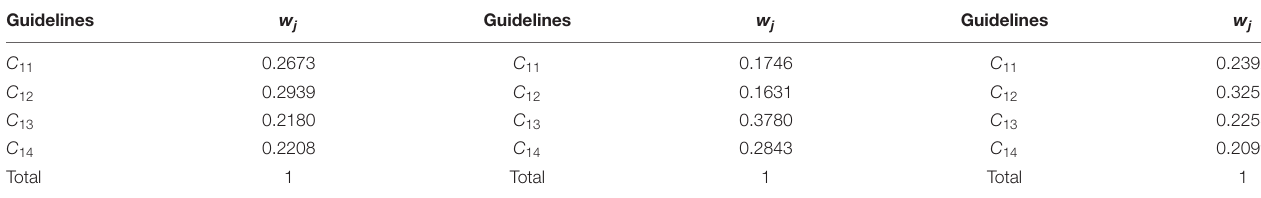
TABLE 9 | The weight matrix of the merged